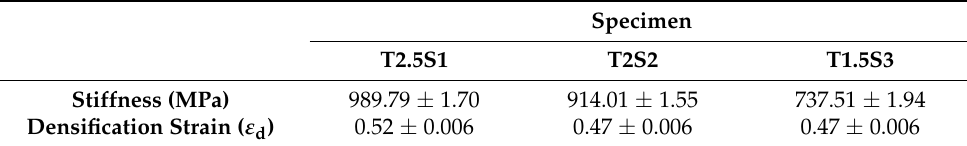
Table 7. Mechanical properties of the biomimetic